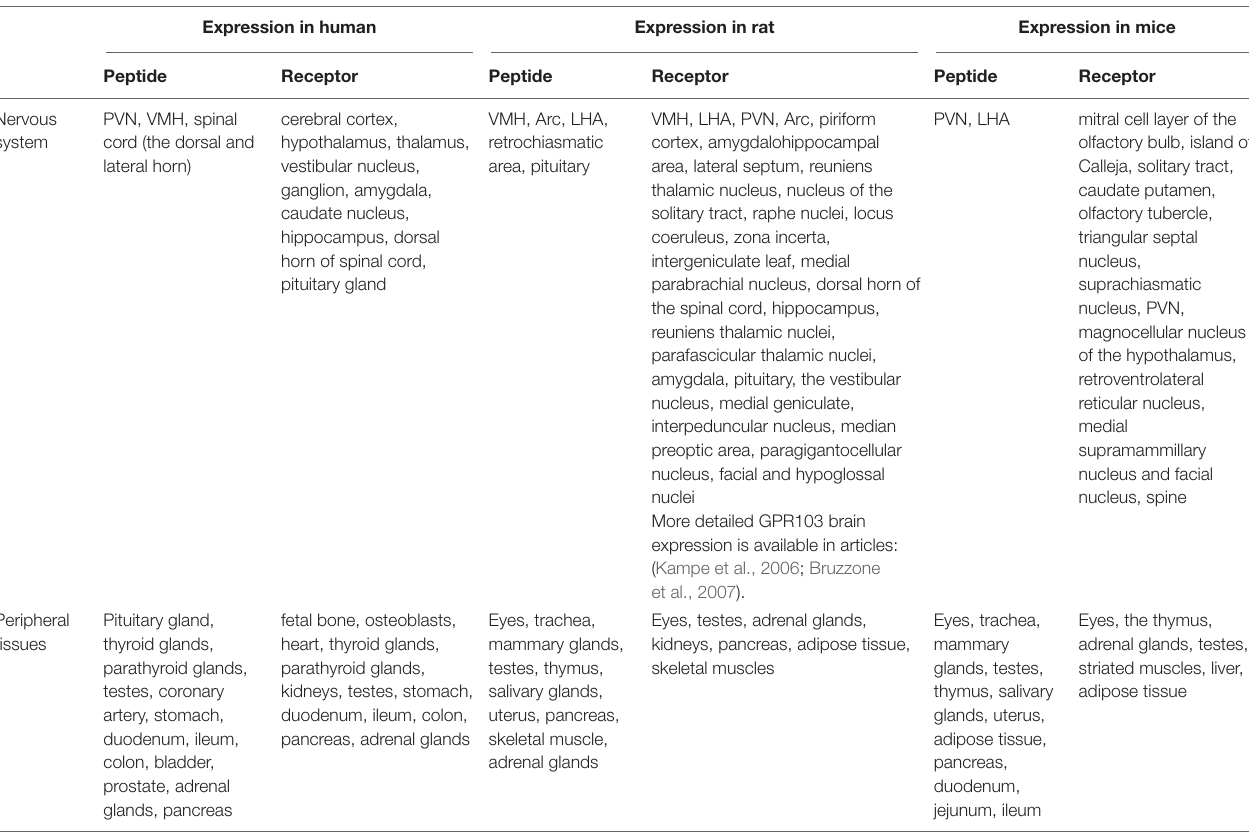
TABLE 1 | Expression of the 26RFa neuropeptide and GPR103 in humans and rodents. Expression in human Expression in rat Expression in mice Peptide Receptor Peptide Receptor Peptide